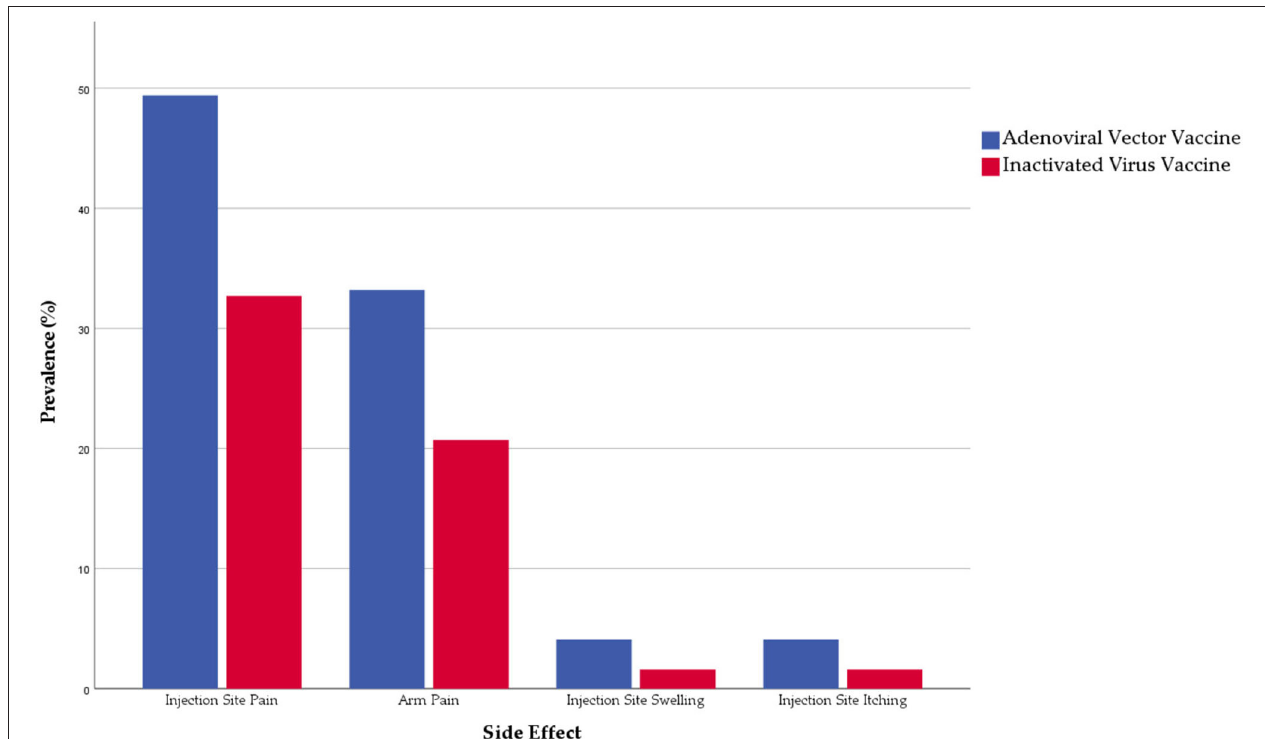
FIGURE 1 | Prevalence of local side effects reported by Algerian healthcare workers ( n = 721).